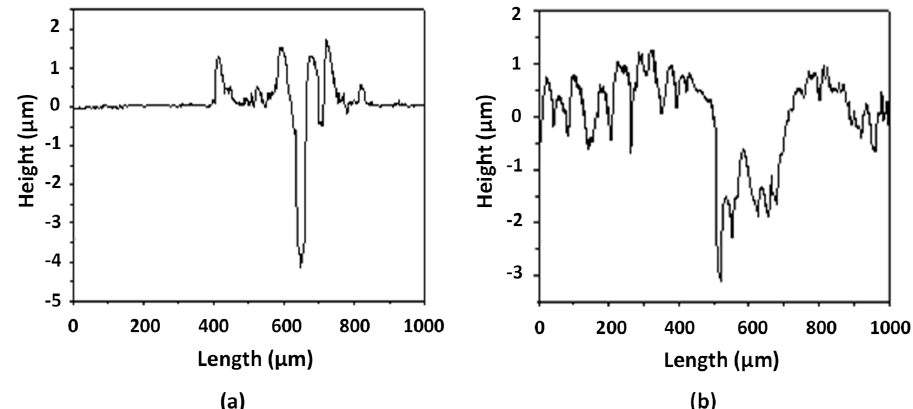
Figure 4. Depth profile of the wearing traces for Ti-C-Ag/OLC 45 ( a ) and Ti-C-Al/OLC 45 ( b ) after 3 N loading force.